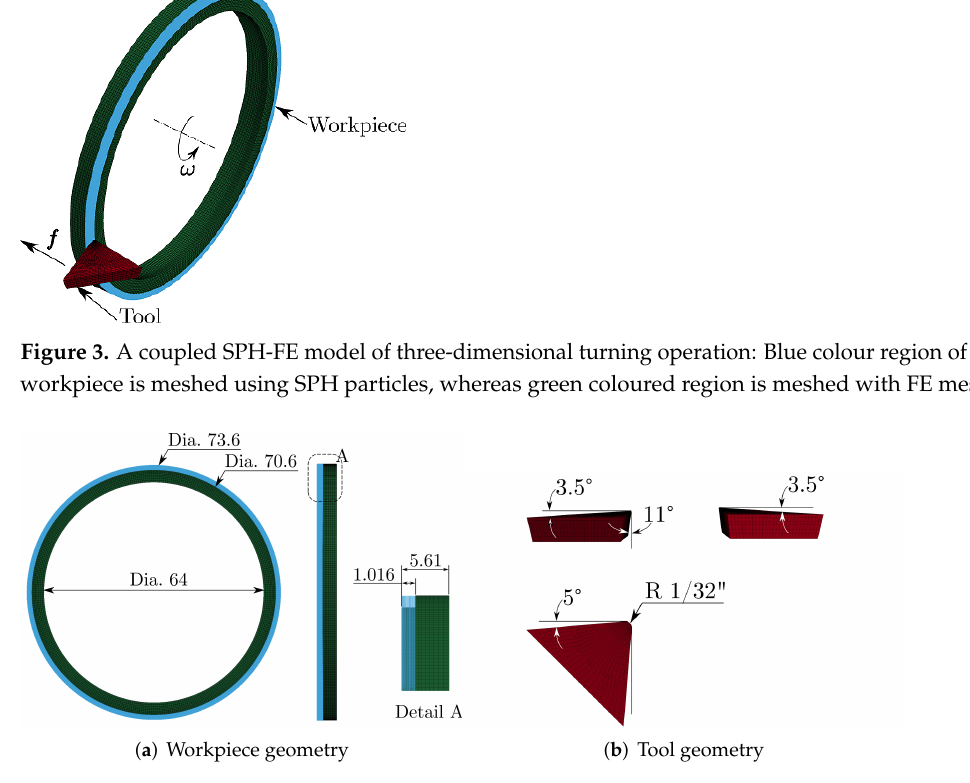
Figure 4. Geometry of workpiece and tool used for 3D machining model. Instead of modelling the complete tool, only the section involved in machining is modelled for the